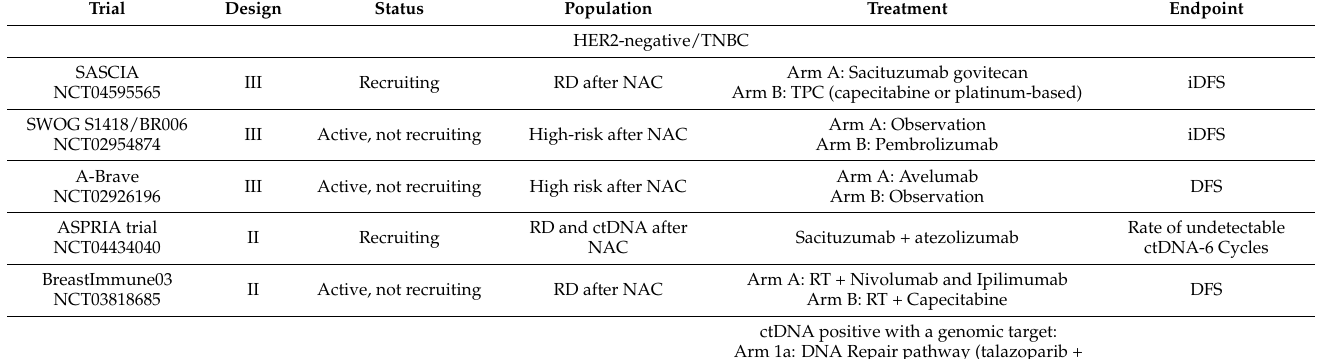
Table 2. Ongoing phase II/III trials in the post-neoadjuvant setting in breast cancer.